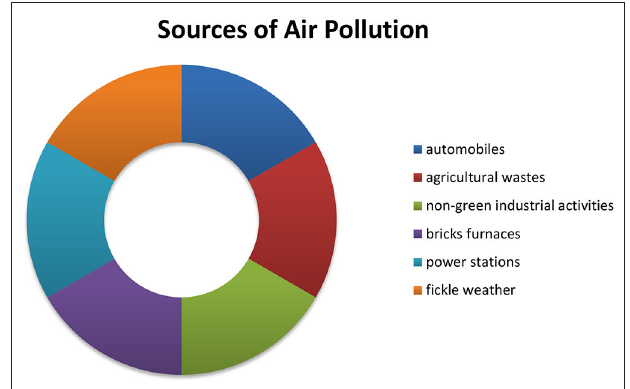
FIGURE 8 | Sources of air pollution in